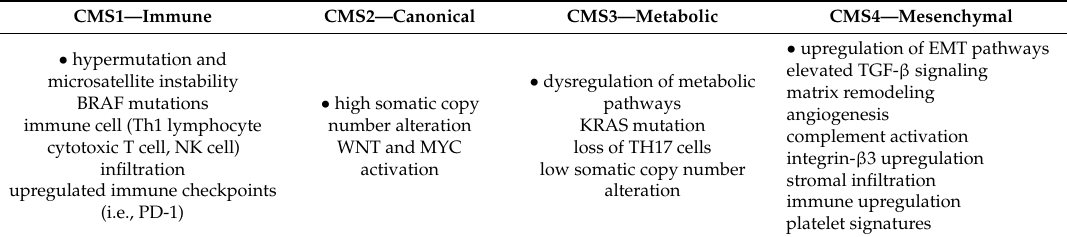
Table 1. Consensus Molecular Classification (CMS) of colorectal